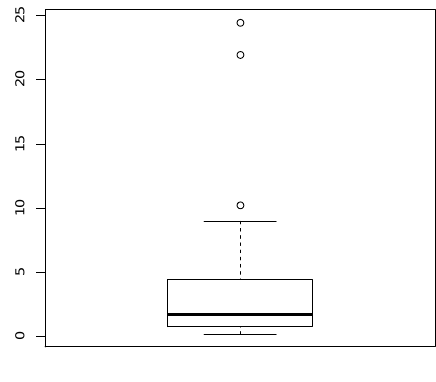
Figure 6 – Box plot of the considered data set.